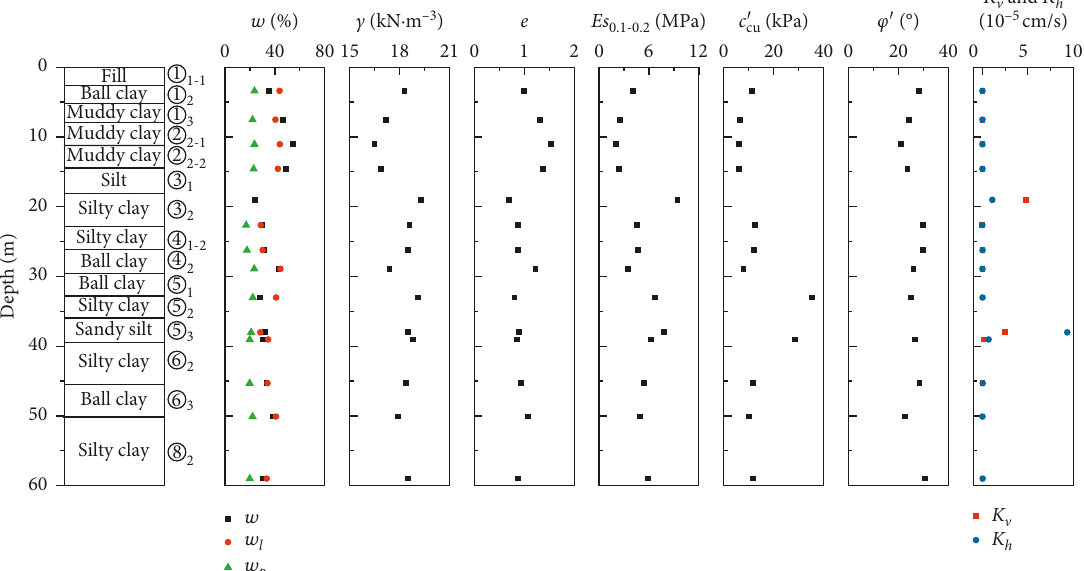
Figure 2: Physical and mechanical index of the soil layer. w —moisture content; w E s 0.1-0.2 —compression modulus; c ability coefficient; K h —horizontal permeability coefficient.